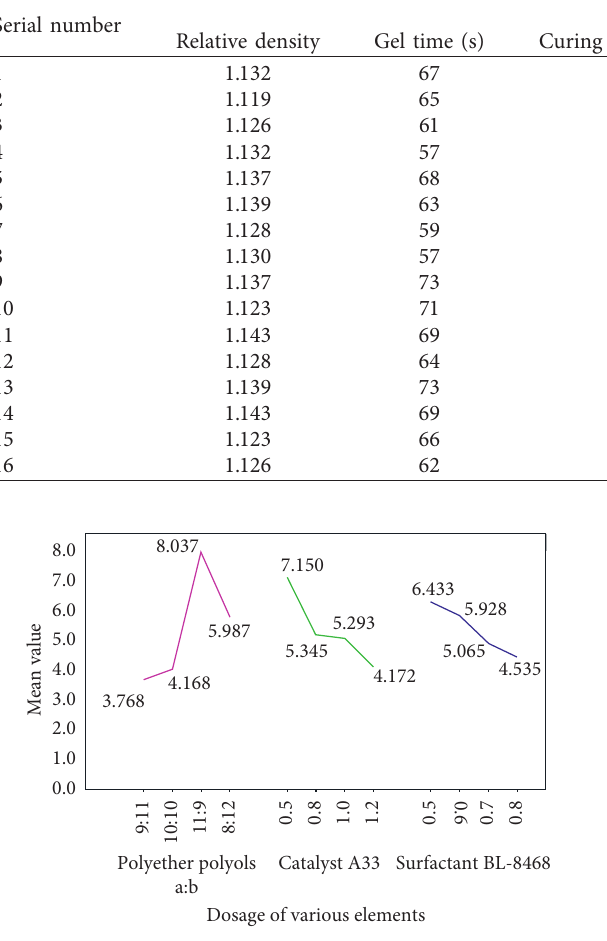
Figure 3: Sensitivity analysis between uniaxial compressive strength and various factors. Table 4: Range analysis of compressive strength. Polyether polyols Factors a